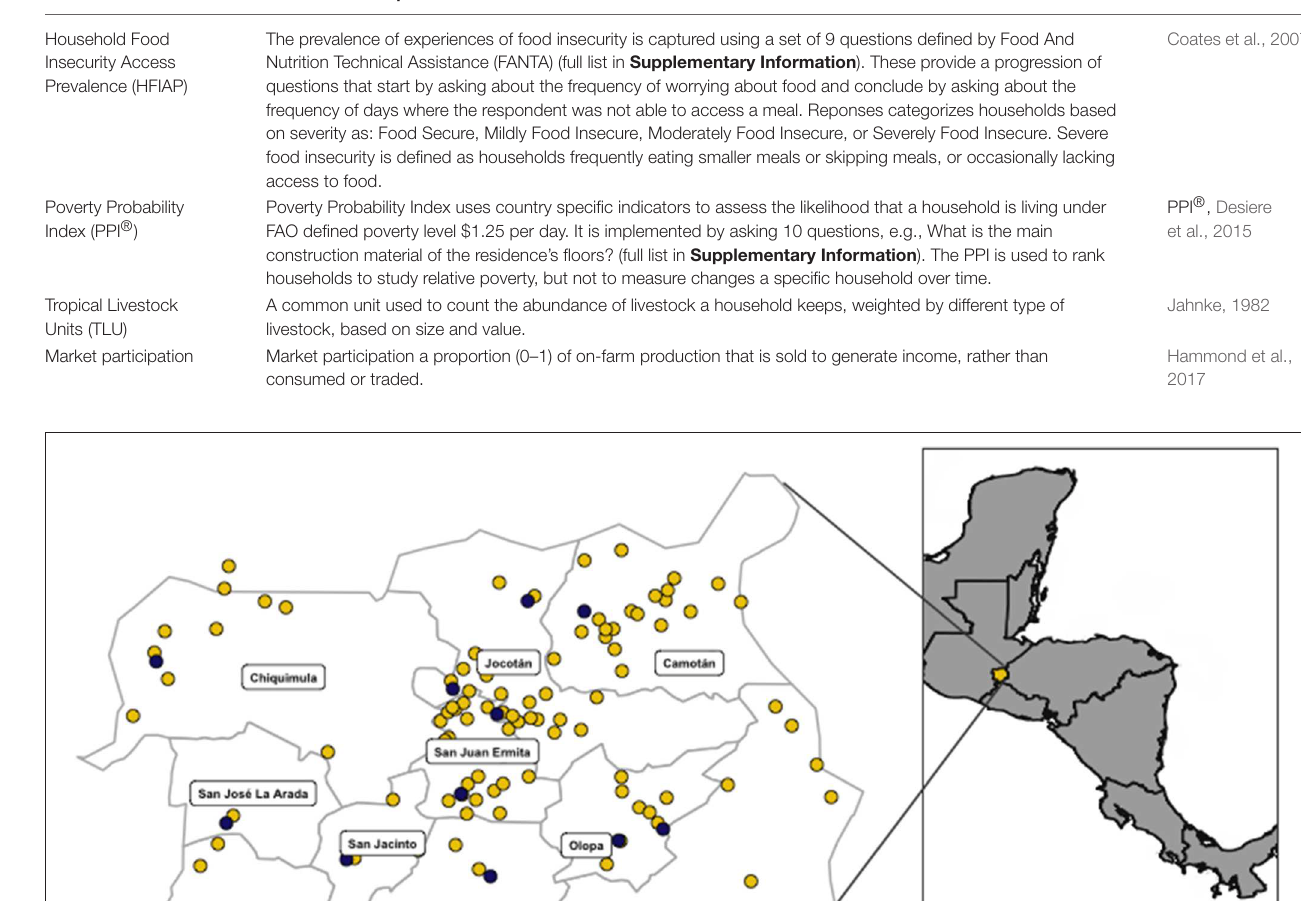
of the interview process and decision to participate.